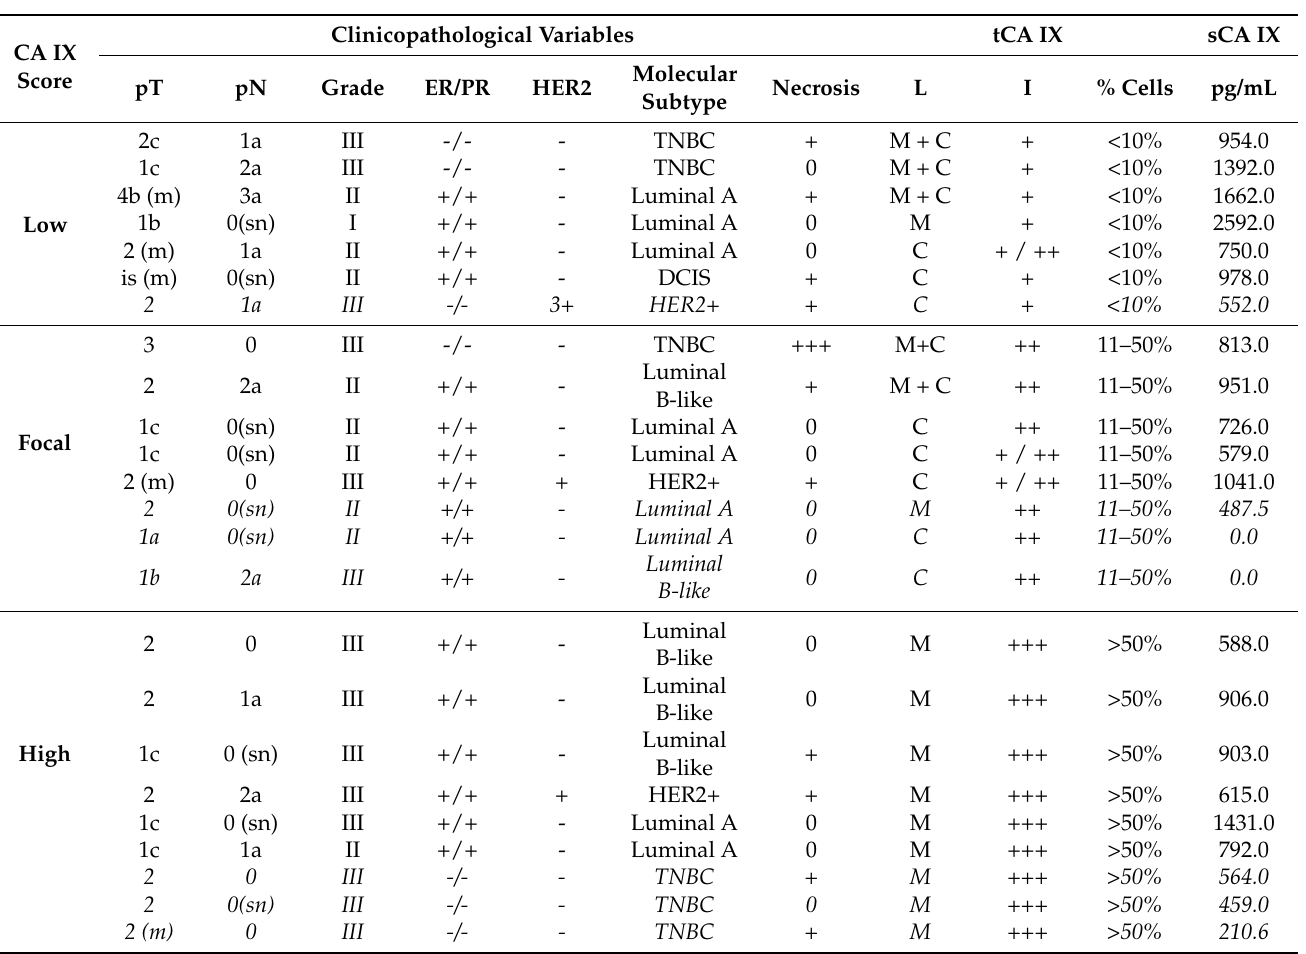
Table 3. Summary table of clinicopathological characteristics of patients with tissue-positive CA IX expression and soluble CA IX levels in their